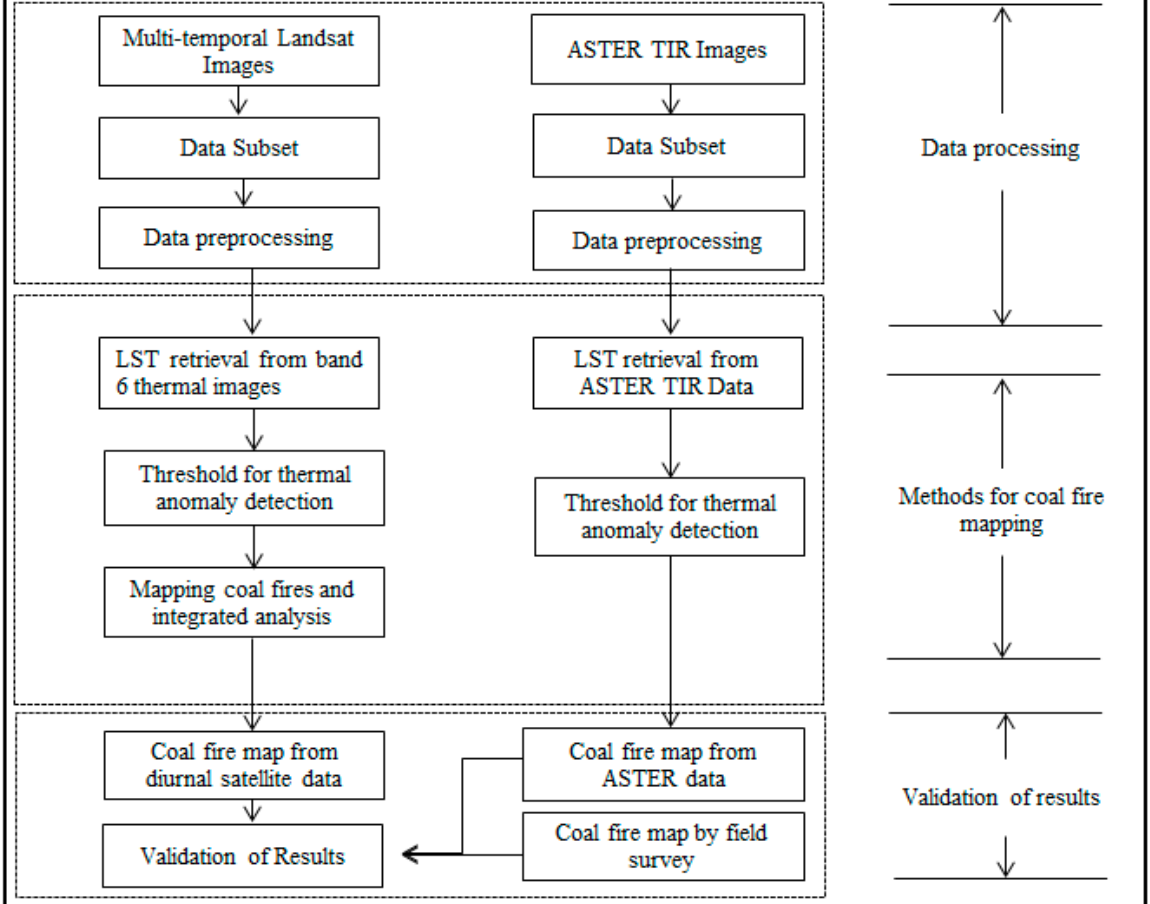
Figure 3. Flow chart for data pre-processing and study